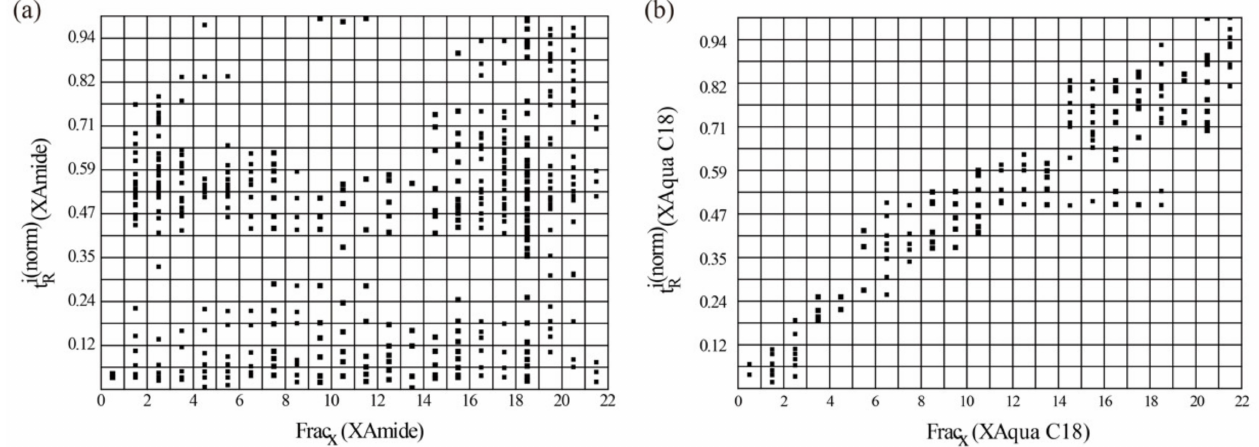
Figure 4. Normalized plots for 2D-LC systems: ( a ) XAqua C18 × XAmide system; ( b ) XAqua C18 × XAqua C18